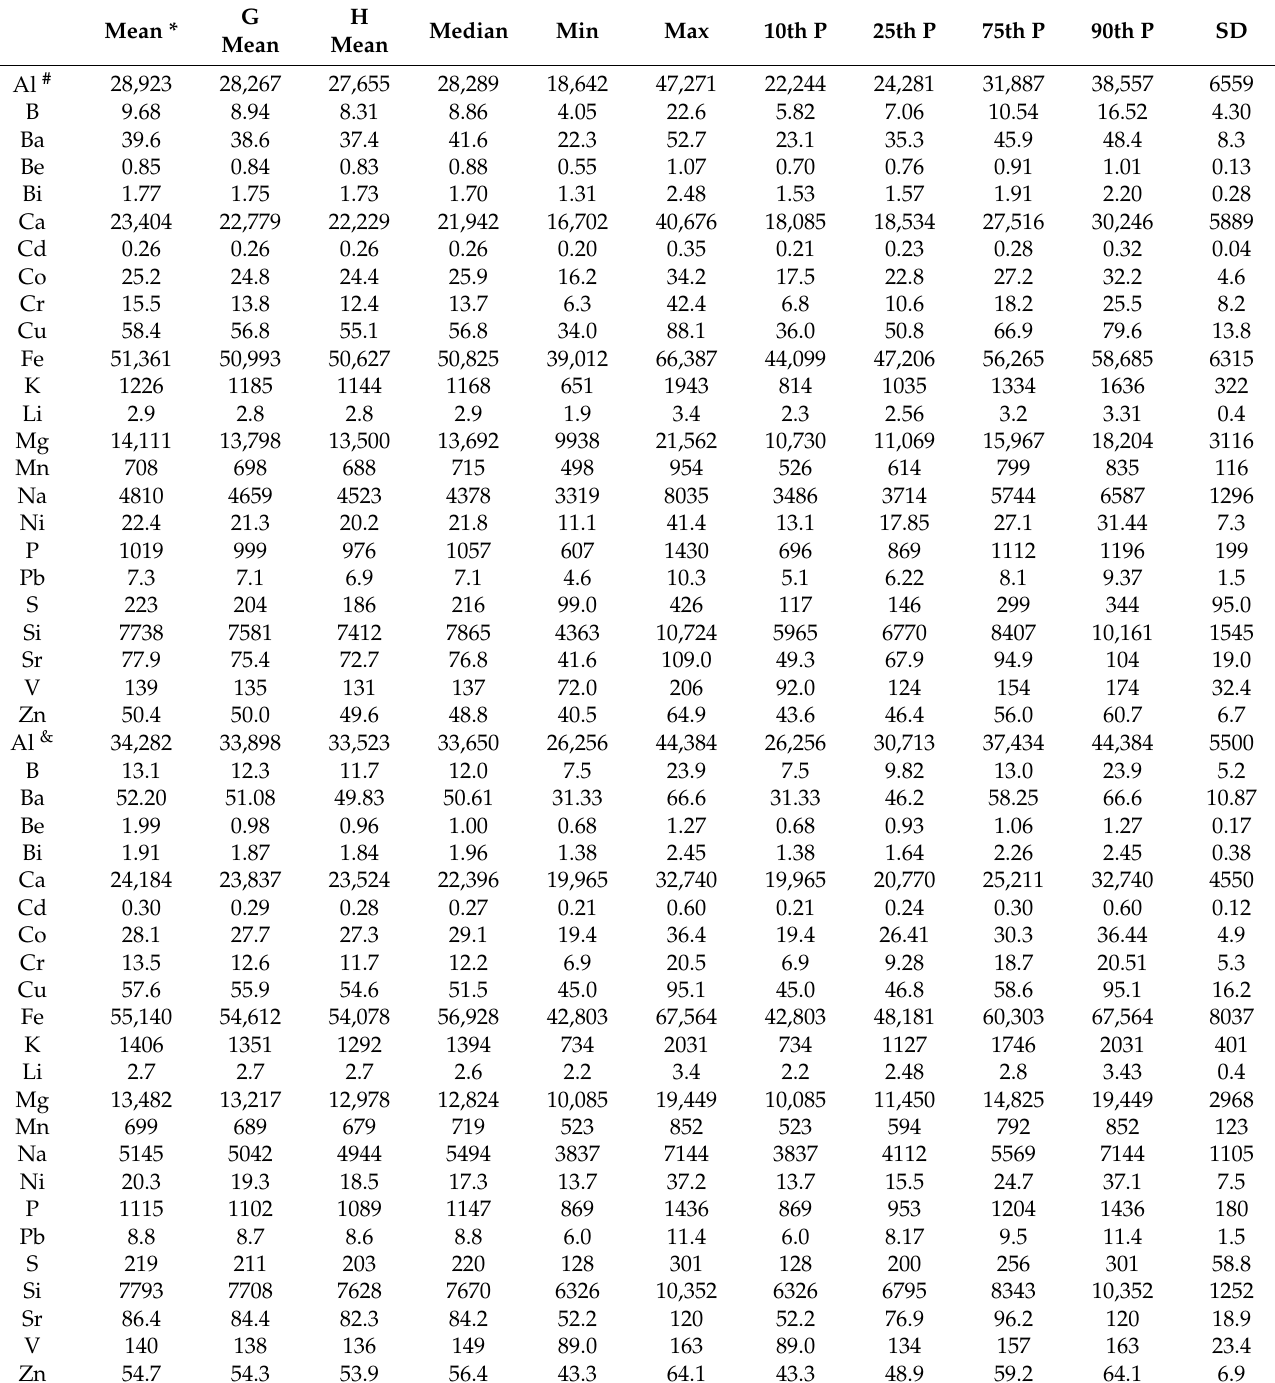
Table 2. Descriptive statistics—river sediments and soils [mg kg − 1